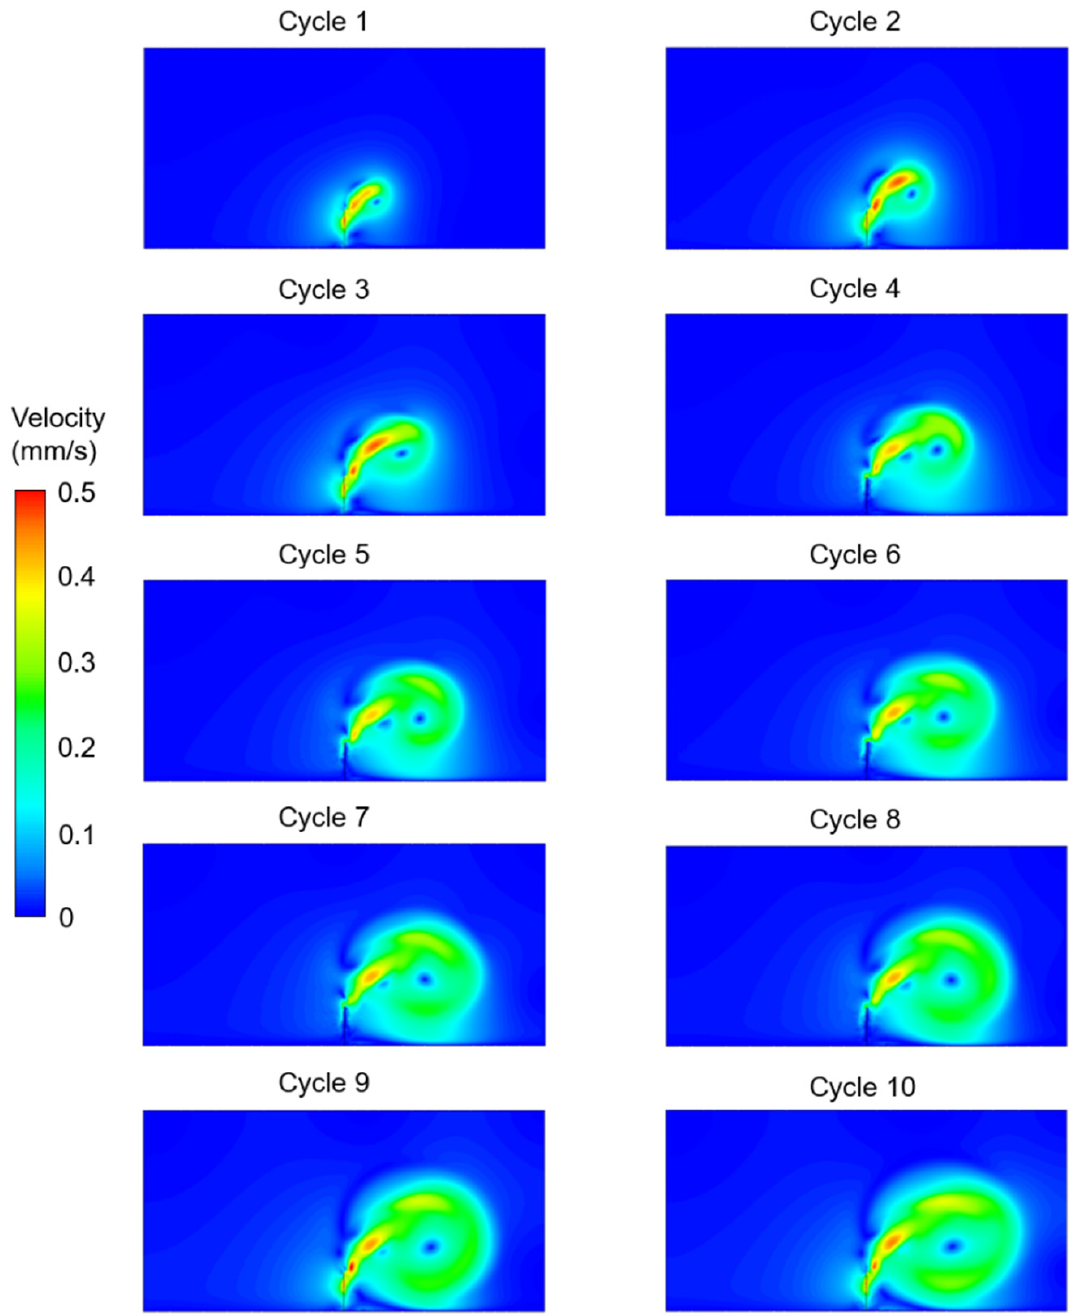
Figure 3. Velocity contour plots of Case 1 for a single cilium with a 30° cilium tilt angle. The flow fields are provided at the end of each ciliary cycle.